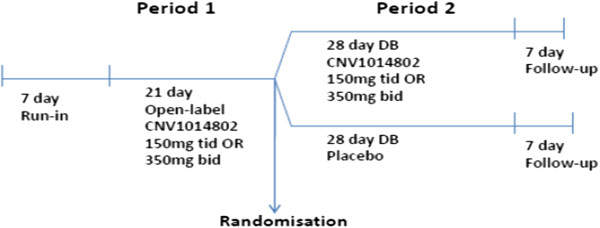
Design of the study.